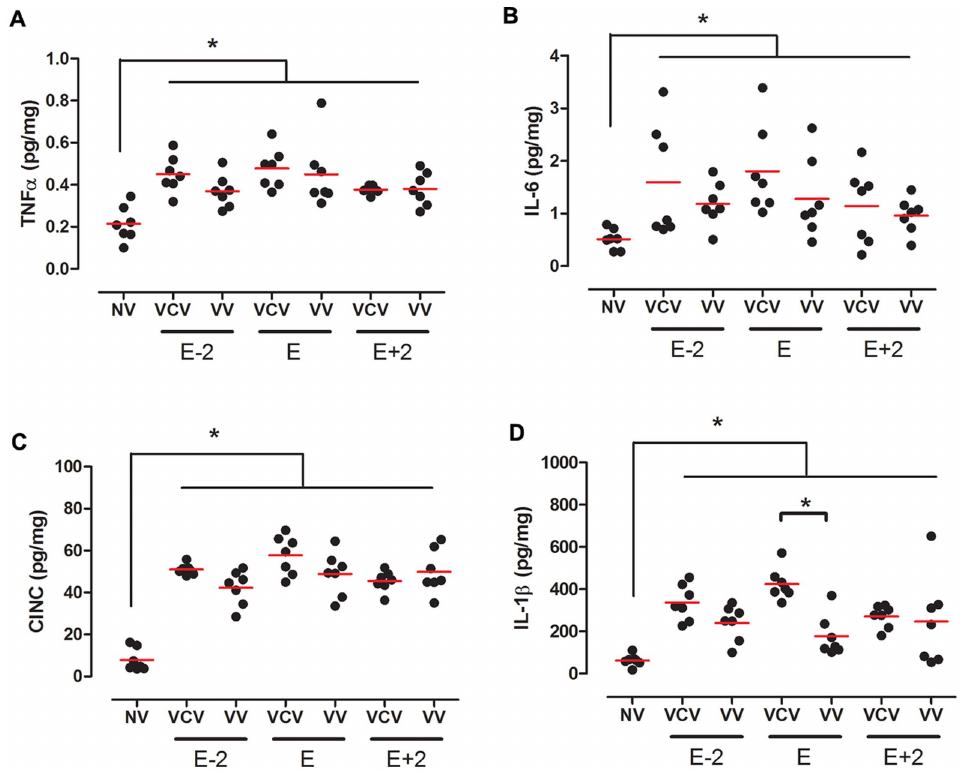
Figure 5. Diffuse alveolar damage score. Score of 0–9 to alveolar edema (A), interstitial edema (B), hemorrhage (C), inflammation (D), atelectasis (E) and the cumulative total score in the groups: VCV_E (volume-controlled mode and PEEP minErs ; n=6), VCV_E + 2 (volume-controlled mode and PEEP minErs plus 2 cmH 2 O; n=6), VCV_E-2 (volume-controlled mode and PEEP minErs minus 2 cmH 2 O; n=6), VV_E (variable ventilation and PEEP minErs ; n=6), VV_E + 2 (variable ventilation and PEEP minErs plus 2 cmH 2 O; n=5), VV_E-2 (variable ventilation and PEEP minErs minus 2 cmH 2 O; n=6). Red lines represent mean values. Ventilatory mode and PEEP effects were tested with two-way ANOVA followed by Tukey post hoc. T-test was used to detect differences between ventilated and non-ventilated groups and then correction by multiple comparison. Statistical significance was accepted at p , 0.05. *p , 0.05.